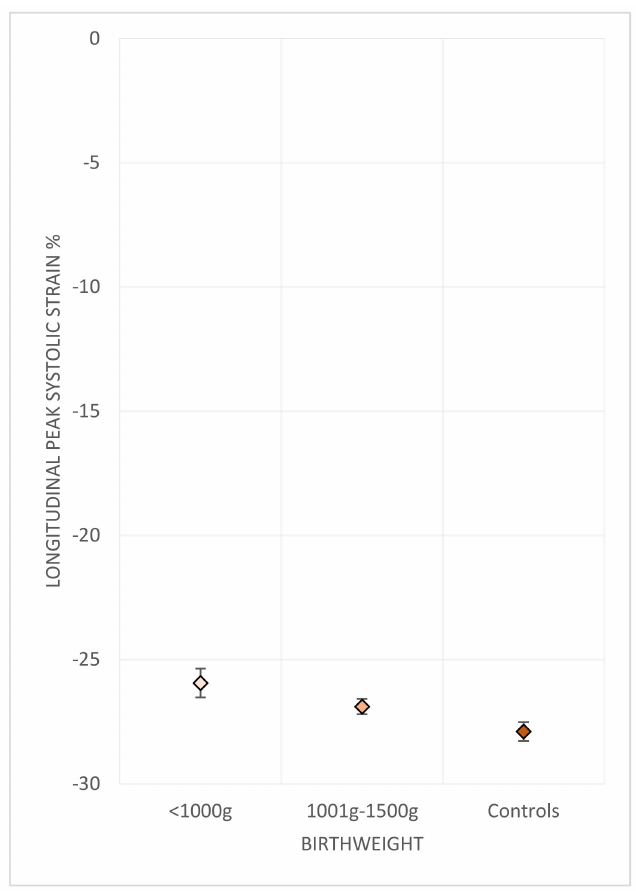
Figure 2. RV freewall strain associated with birth weight. RV longitudinal freewall strain compared between categories of extremely low birth weight (ELBW, <1000 g) and VLBW (<1500 g). Diamonds indicate the sex-adjusted mean. Bars indicate the standard